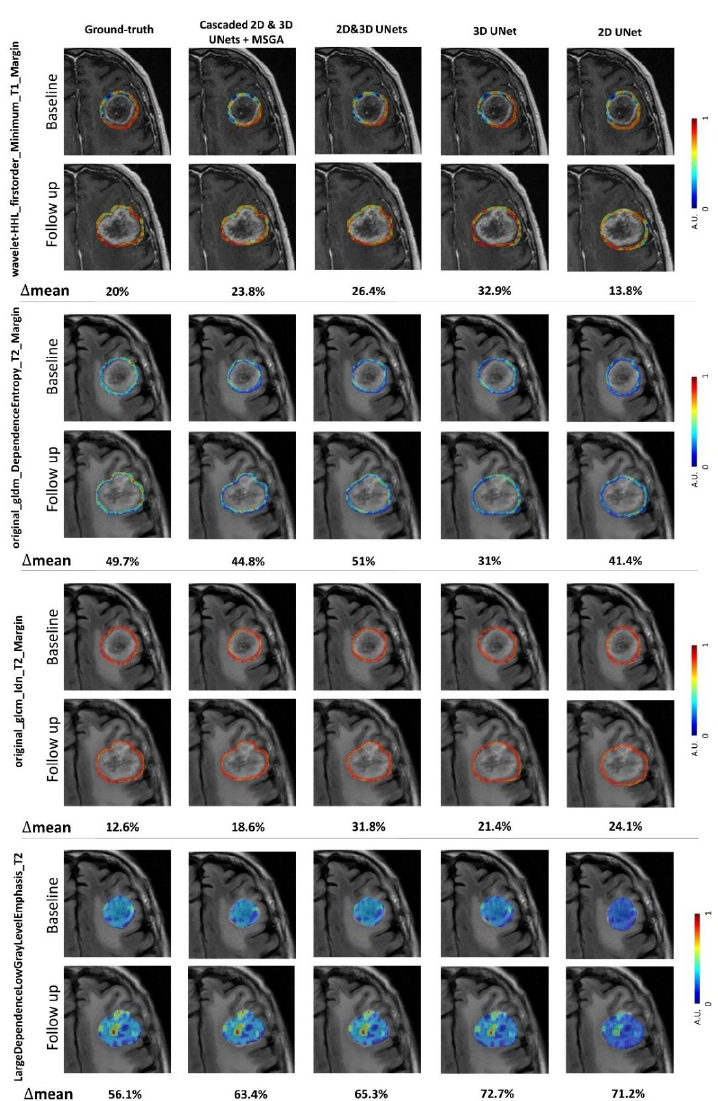
Figure 3. Representative parametric maps of the top four selected features based on the ground-truth (Table 2) overlayed on the associated MR images acquired at the baseline and the first follow-up from a representative tumour with an LF outcome. The parametric maps are shown for the ground-truth mask and the segmentation masks generated automatically using different models. Δmean for each feature is the mean relative change from the baseline at the first follow-up that is calculated for different masks.